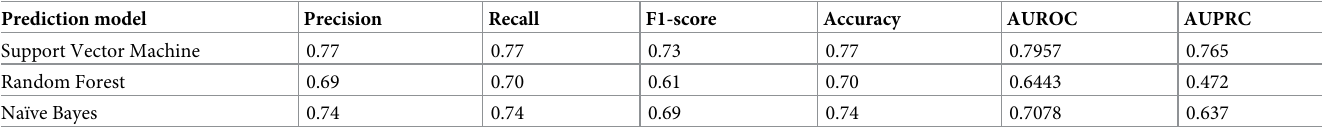
Table 3. Summary of the comparison of IgAN with ’Crescent proportion’ and ’Global crescent proportion’ model performance. Prediction model Precision Recall F1-score Accuracy AUROC AUPRC Support Vector Machine 0.77